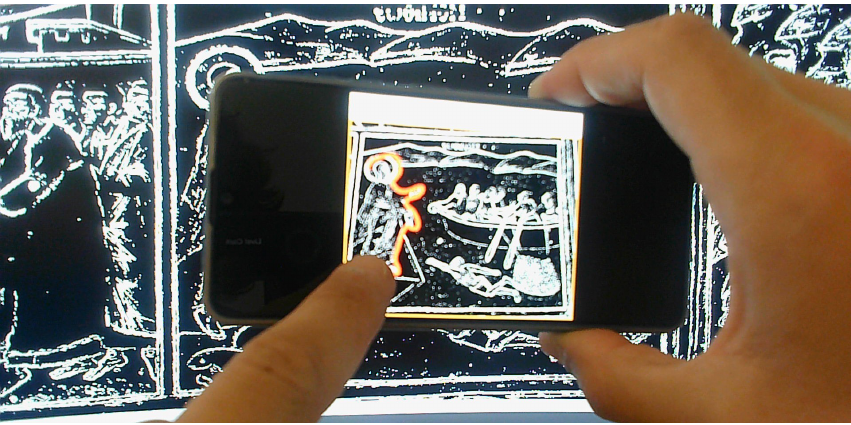
Figure 1. Interaction method: (i) point and touch.